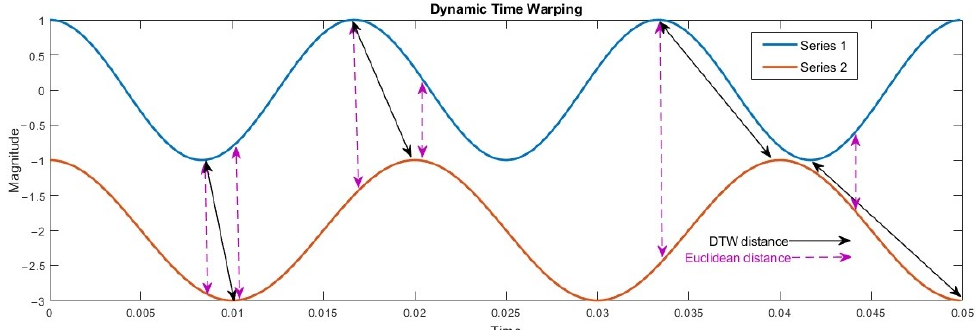
Figure 2. Dynamic time warping (DTW) (solid arrowed lines) versus Euclidean distance (dotted arrowed lines) for two arbitrary time series. Reproduced from [41] (CC BY 4.0).